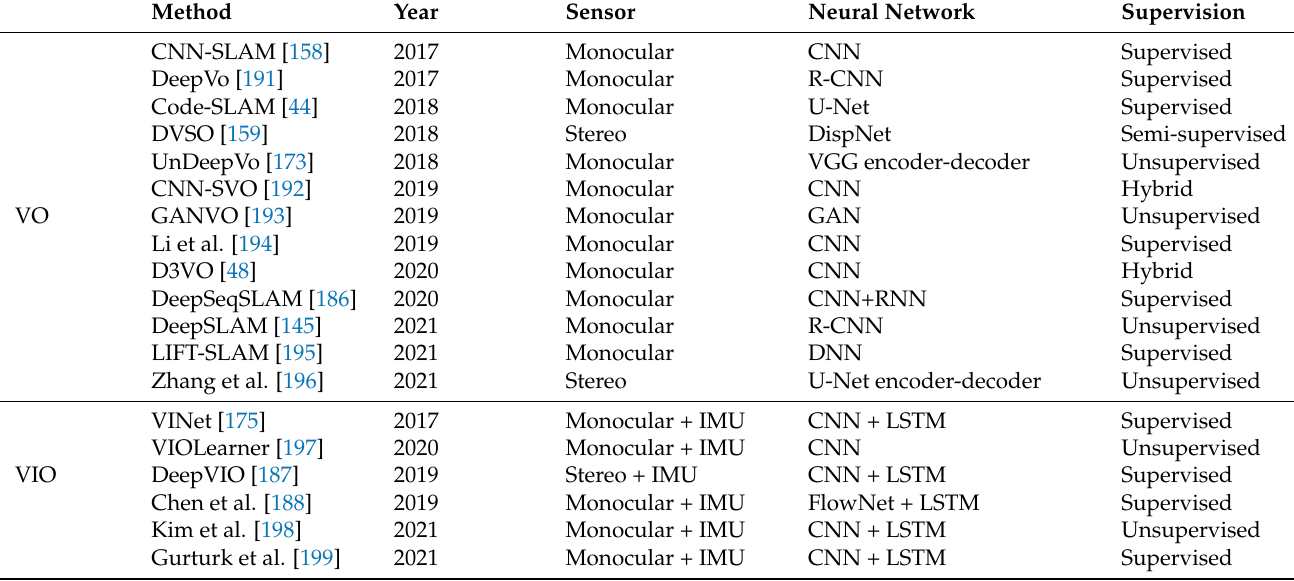
Table 10. An excellent algorithm combining neural networks with